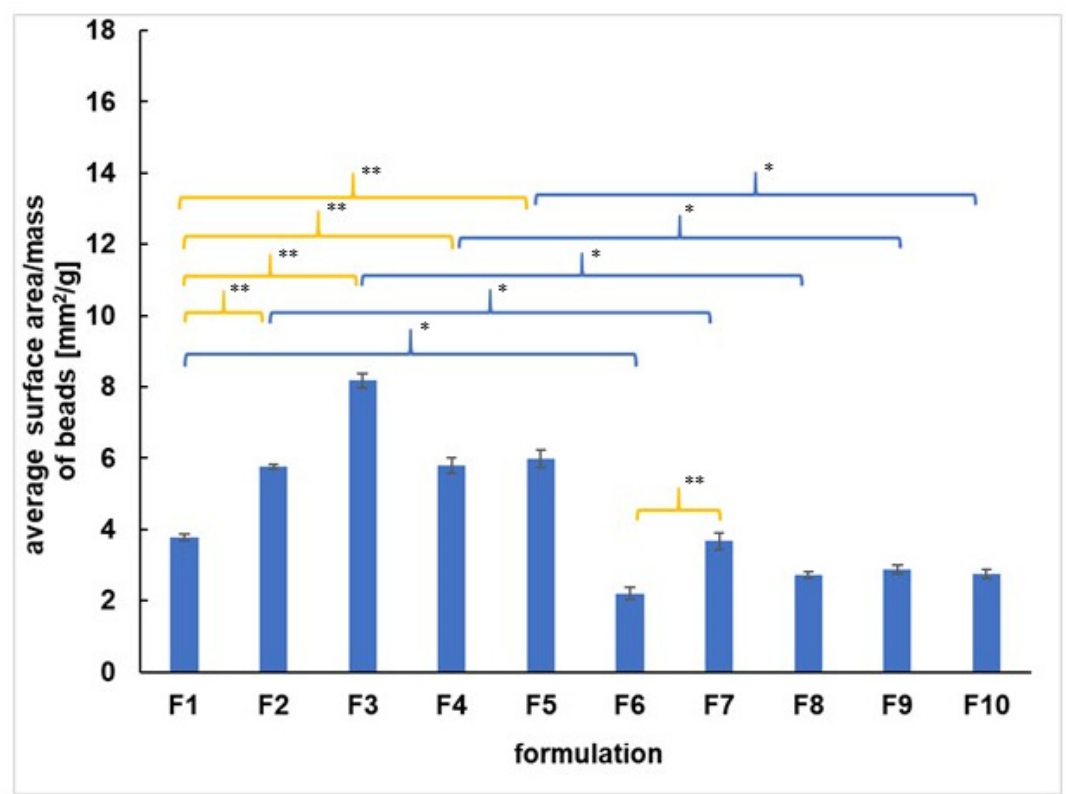
Figure 2. The average surface area per mass of coated beads F1–F10. Significant differences between the average values of surface area per mass of F1–F10 were marked, p < 0.05; * indicates the differences connected with 5-ASA incorporation, ** shows the discrepancies resulting from incorporation of the synthetic polymer.